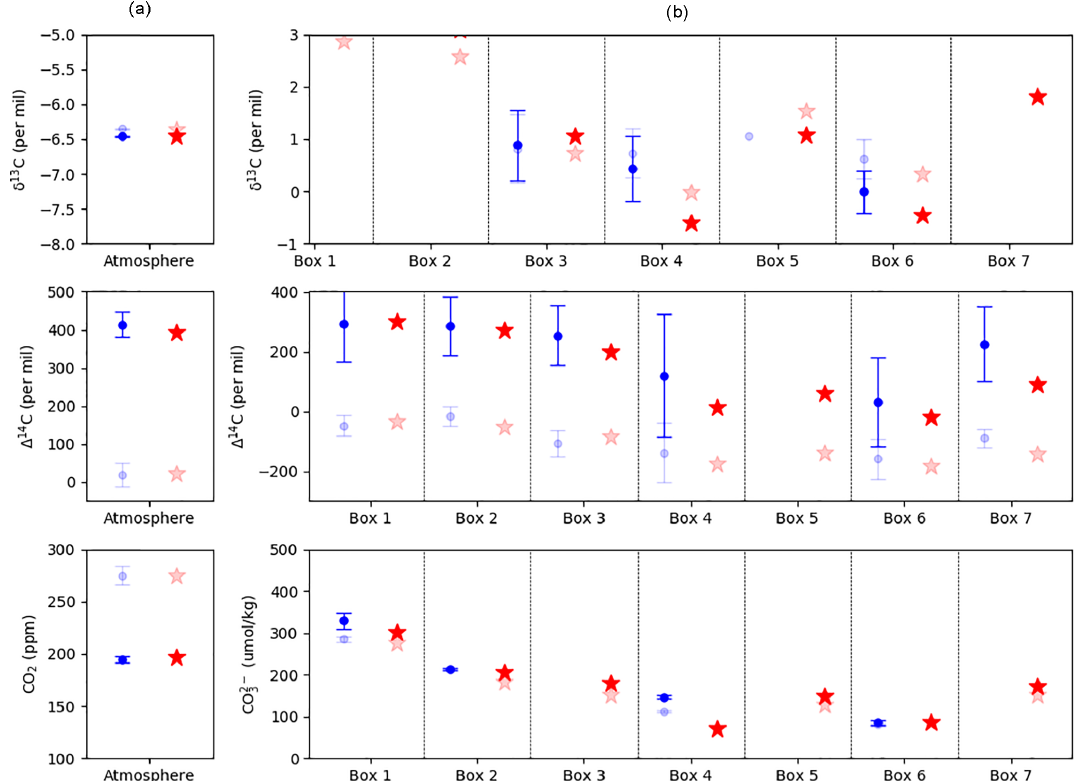
Figure 11. LGM atmosphere- and ocean-data-optimised model results. (a) The atmospheric carbon cycle results from SCP-M (red stars) plotted against LGM average data values (blue dots) with standard error bars. (b) The SCP-M ocean results plotted against LGM average ocean data where available. Corresponding Holocene data and results shown with transparent markers. The data-optimised model results show a close match for the LGM atmospheric data and most of the ocean data. The ocean δ 13 C and (cid:49) 14 C data show an increased compo- sitional gradient between shallow–intermediate depths (boxes 1–3) and deep–abyssal depths (boxes 4 and 6), an outcome replicated in the corresponding model results mainly by a slower GOC. Data sources are shown in Table